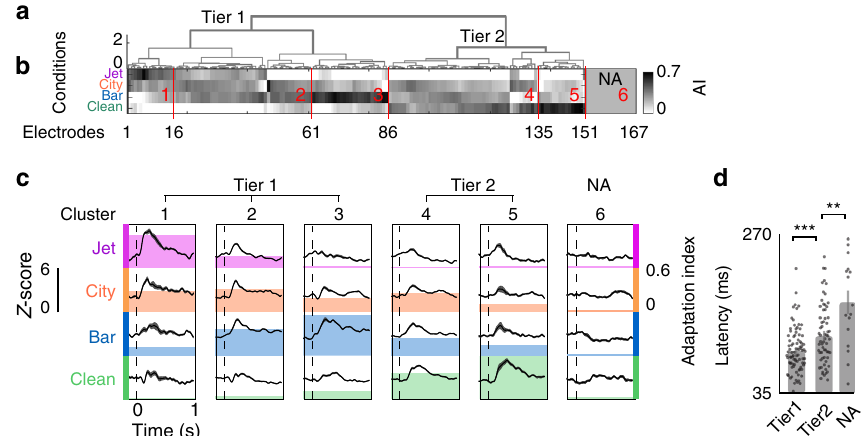
Fig. 5 Diversity of adaptation patterns across electrodes. a , b Hierarchical clustering of adaptation indices (AI) across four background conditions. c Average response of electrodes in each cluster to each background condition, aligned by the time of transition. The colored backgrounds show the average adaptation indices for each cluster and condition. d Average latency of electrodes from the top two clusters (tier 1, tier 2) and a nonadaptive cluster (mean ± s.e.m., N tier1 = 86, N tier2 = 65, N NA = 16, t -test, ** p < 0.05, *** p < 0.01)